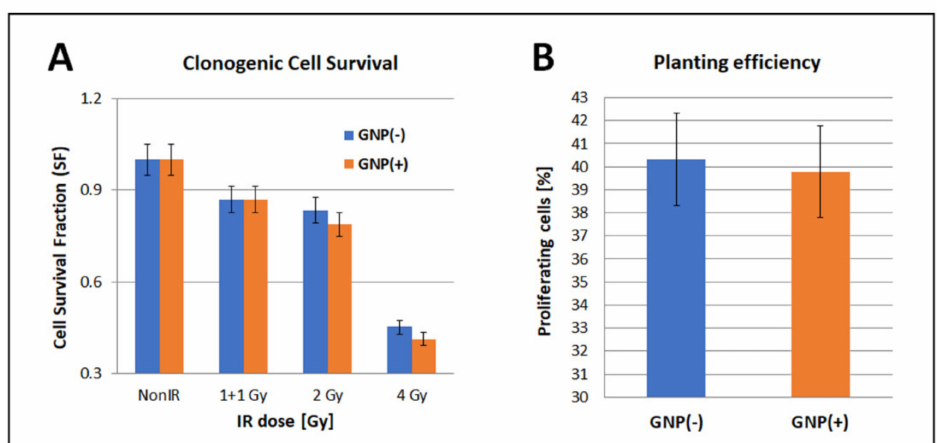
Figure 16. Clonogenic survival of SkBr3 cells upon exposure to increasing γ -ray doses in the presence (GNP(+)) or absence (GNP( − )) of 10-nm gold nanoparticles (Aurion, 0.4 µ g/mL for 18 h). ( A ) Clono- genic survival fraction (SF) normalized to the plating efficiency. Blue bars—GNP( − ) cells, orange bars—GNP(+) cells. ( B ) Influence of GNPs on plating efficiency of non-irradiated